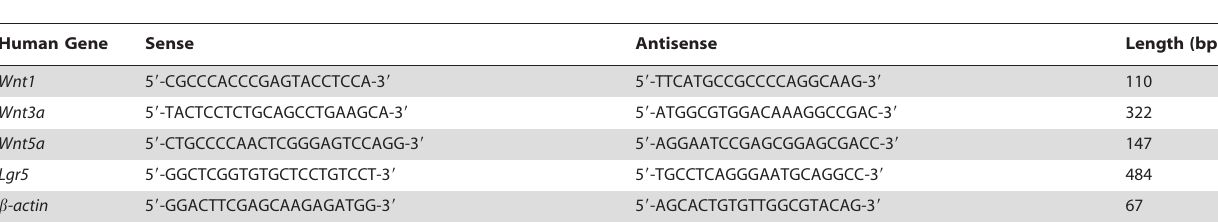
Table 3. Primer sequences of specific PCR products for each gene analyzed.